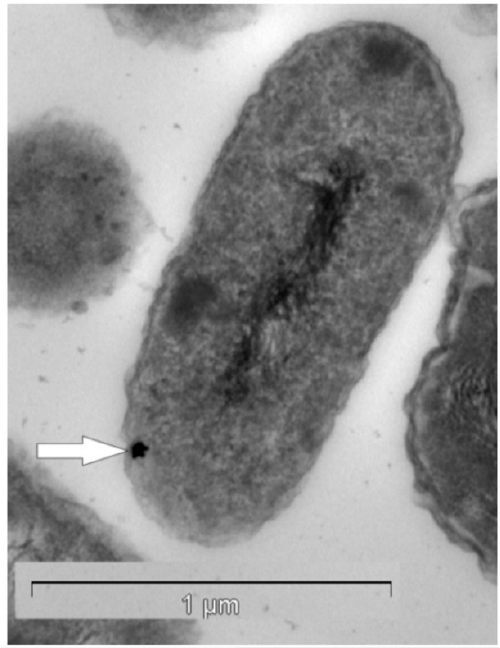
Figure 1. Transmission electron micrograph of a Cupriavidus metallidurans ultra-thin section containing a gold nano-particle (white arrow) in the periplasm. Reproduced from [53] with permission of PNAS, Copyright 2009 National Academy of Sciences.